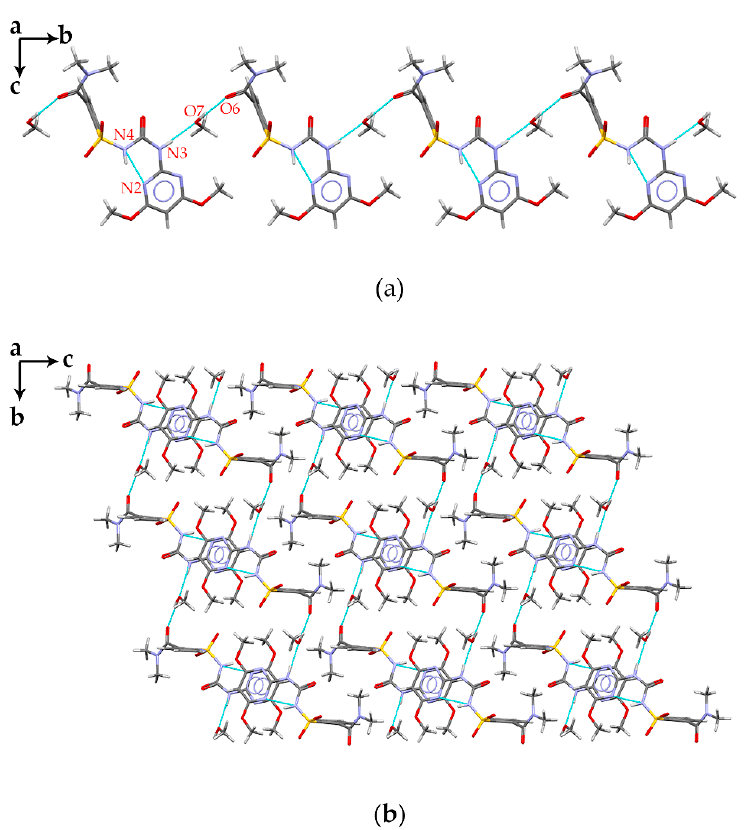
Figure 3. ( a ) 1-D chain formed by the hydrogen bonds along the b axis in NS-MeOH. ( b ) Packing motifs formed by the hydrogen bonds in NS-MeOH.